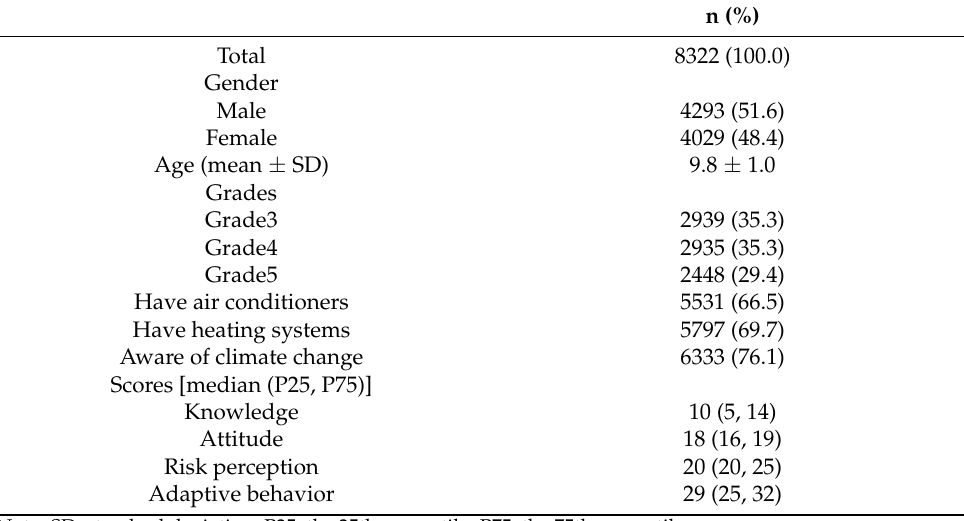
Table 1. Statistics summary.